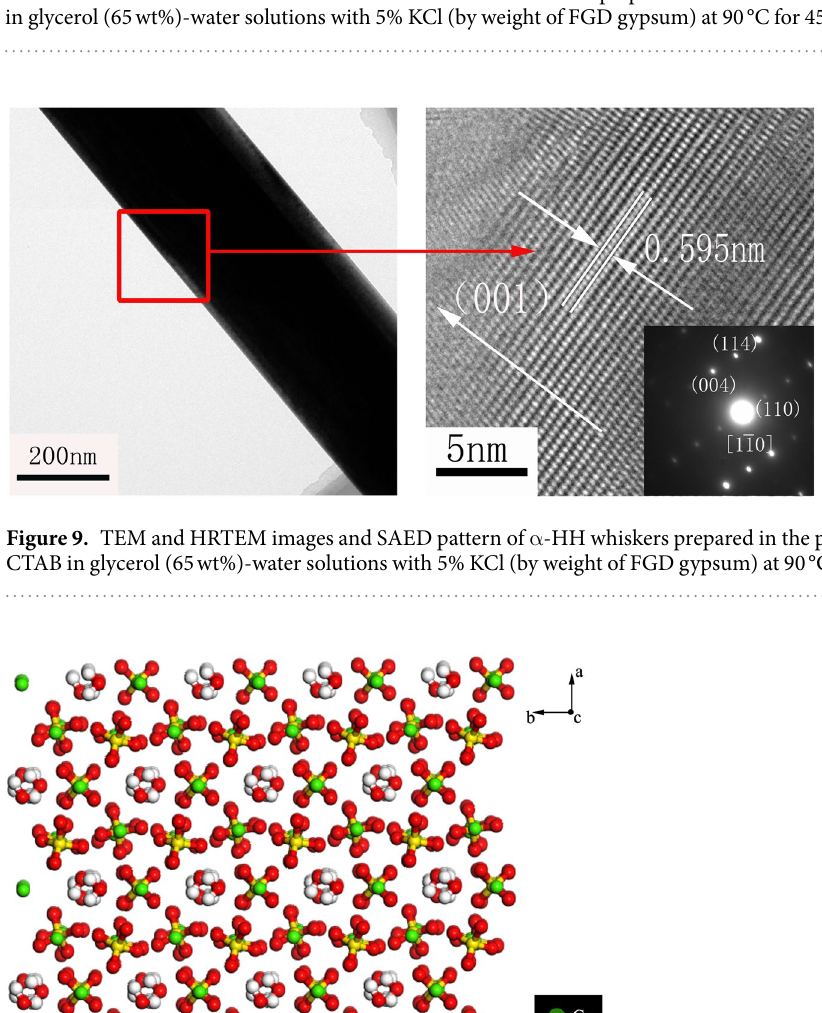
Table 2. C and N surface atomic concentration of α -HH whiskers prepared with different CTAB concentration